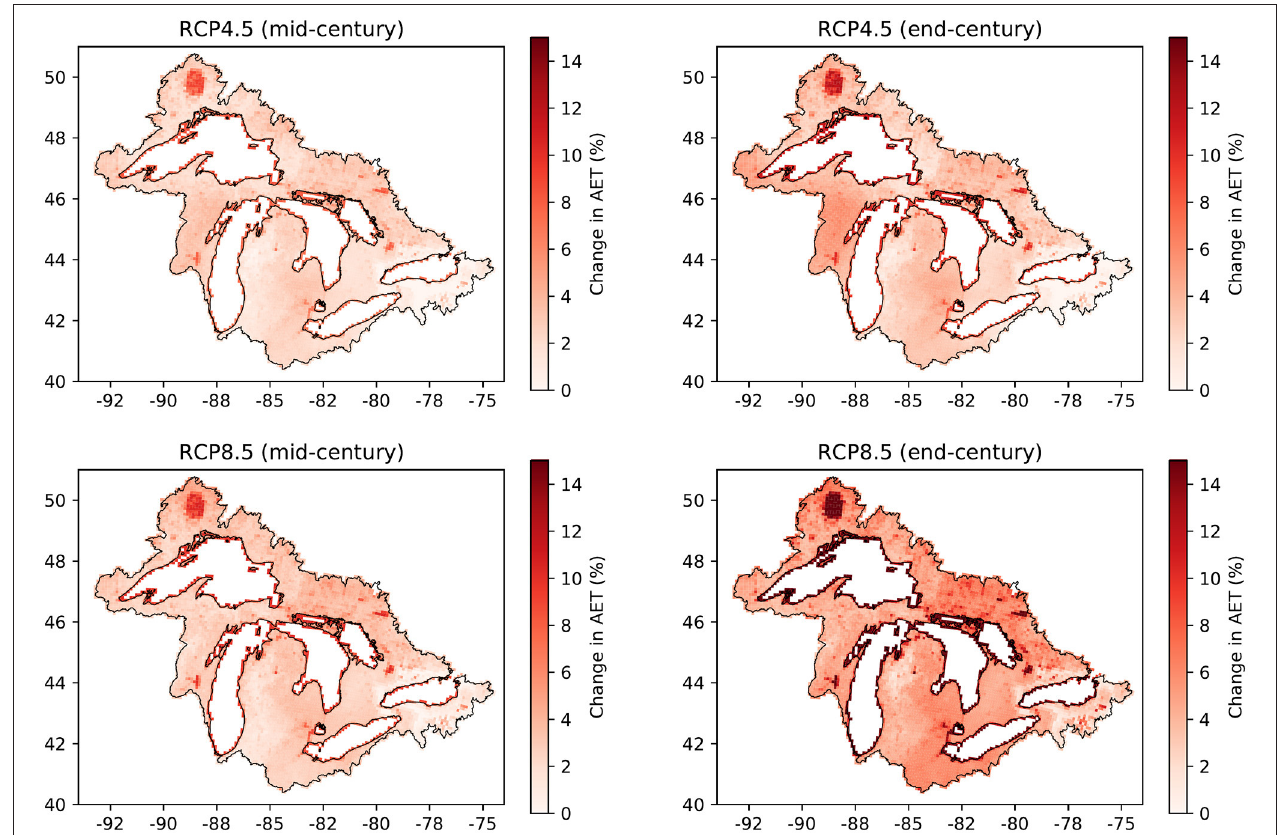
FIGURE 13 | Percentage changes in annual mean actual evapotranspiration (AET) of GL basin for RCP 4.5 and RCP 8.5 scenarios both mid- and end-century